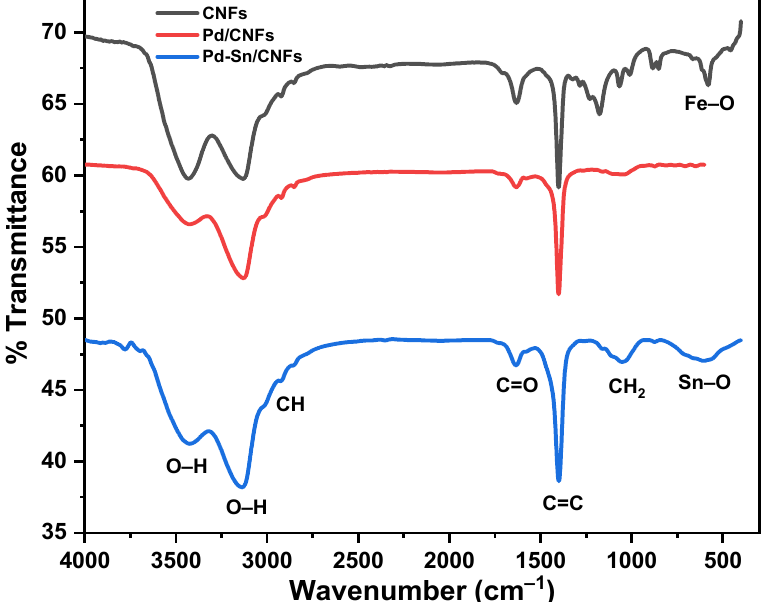
Figure 2. FTIR spectra of carbon nanofibers (CNFs) support, Pd/CNFs and Pd-Sn/CNFs